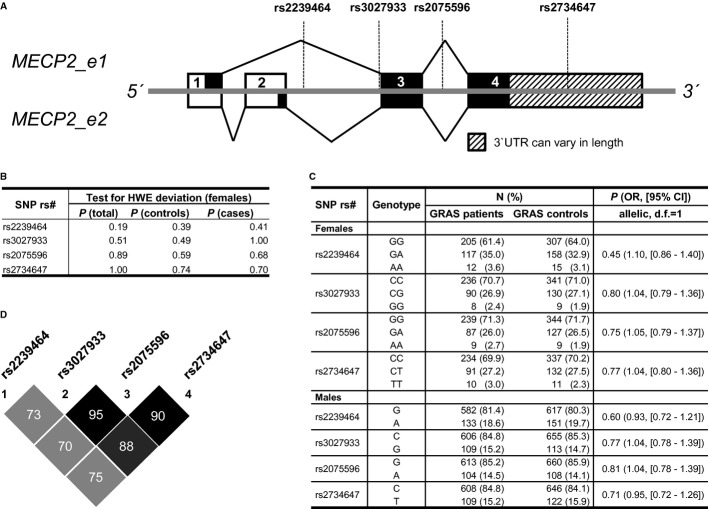
Basic genetics of MECP2: Gene structure, Hardy-Weinberg statistics, linkage disequilibrium, and case-control analysis in schizophrenic (GRAS) patients and healthy individuals.A Schematic overview of MECP2 isoforms e1 and e2, including SNP positions. Digits depict exon numbers, solid black lines exon usage for the respective isoform. Dashed lines denote SNP positions. Black fillings in boxes denote coding sequence, isoform-specific in exons 1 and 2.B Test for deviation from Hardy-Weinberg-Equilibrium (HWE) in females only due to X-chromosomal location of MECP2.C Case–control association analysis - separate for both genders - reveals similar distribution of SNPs in patients and controls.D Linkage disequilibrium for all included GRAS patients and controls.